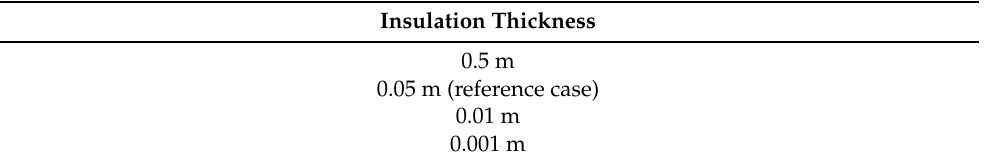
Table 9. Variation of insulation